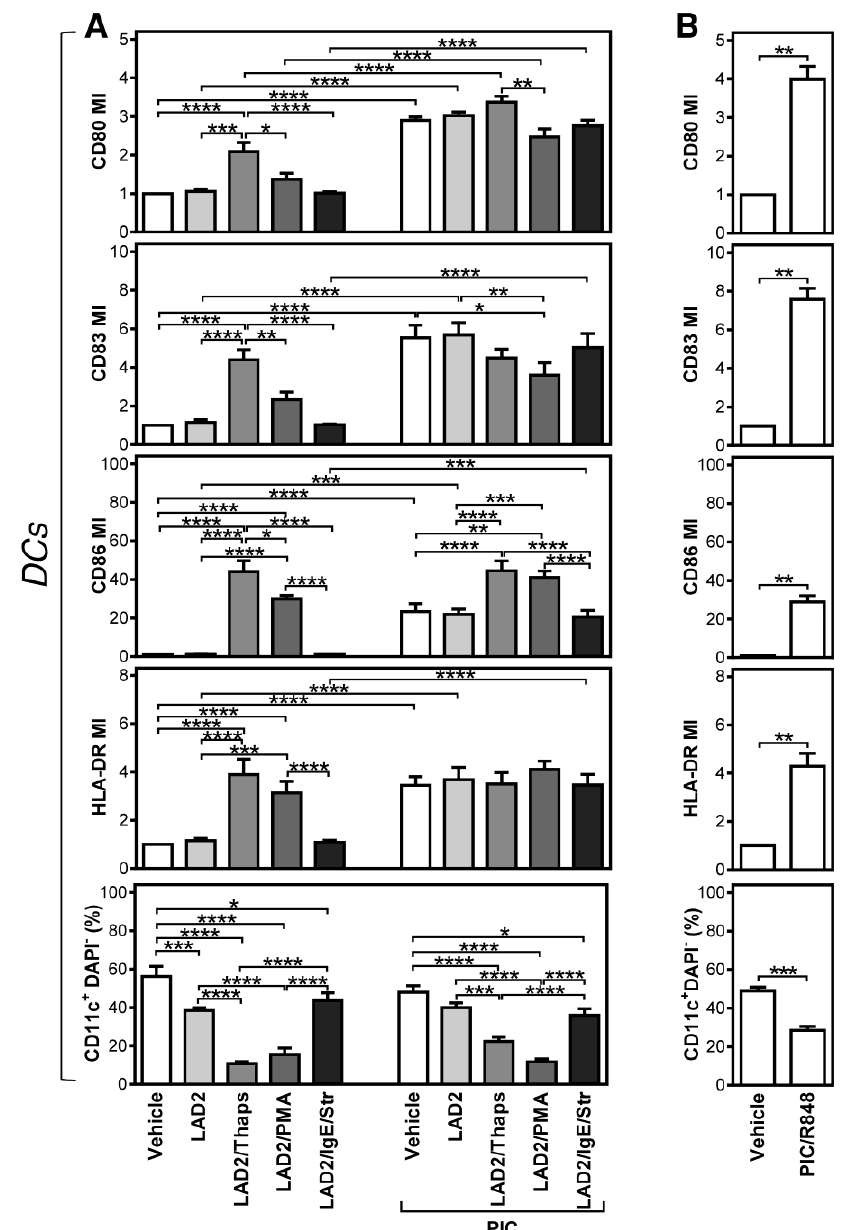
Figure 3. Evaluations of the impact of stimulated LAD2 MCs on the maturation of monocyte-derived DCs produced in the serum-containing medium. ( A ) The extent of DC maturation was evaluated through the maturation index (MI). The DC MI was calculated from the mean fluorescence intensities (MFIs) of the DC maturation marker staining in Figure 2 as the ratio between MFIs of the marker staining of the stimulated and non-stimulated (iDCs) DCs. The calculated DC MIs of individual samples were evaluated. The proportions of viable DCs (DAPI-CD11c+) were taken from Figure 2. ( B ) Monocyte-derived iDCs were produced in the serum-containing medium and matured for 20–24 h in F-bottom 96-well plate wells (0.2 × 10 6 of iDCs in 200 µL of culture medium) in the presence or absence of poly I:C (PIC, 25 µg/mL) with R848 (10 µM). The DC MIs were calculated as in ( A ) and evaluated. In ( A ) and ( B ), bars represent the mean of values and SEM determined in each group. The significance of differences among the group of cells is indicated (* p < 0.05, ** p < 0.01, *** p < 0.001, **** p < 0.0001; ( A ): n = 4 donors, 1-way ANOVA with the Tukey post-test; ( B ): n = 4 donors, paired 2-tailed Student’s t